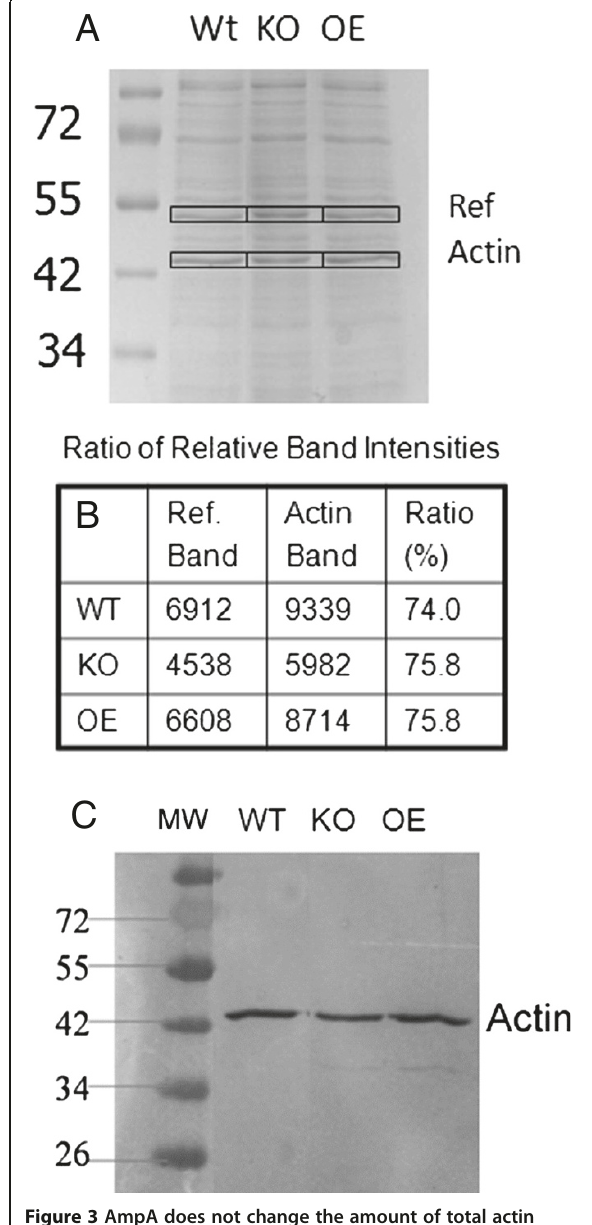
Figure 3 AmpA does not change the amount of total actin protein in the cells. A ) Polyacrylamide gels were loaded with total protein from 1 x 10 5 cells per lane and stained with